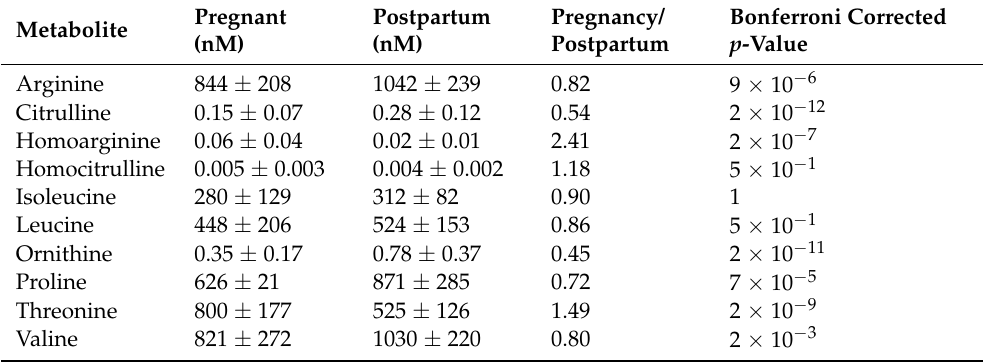
Table 3. Pregnant and postpartum plasma concentration data from targeted confirmatory analysis.